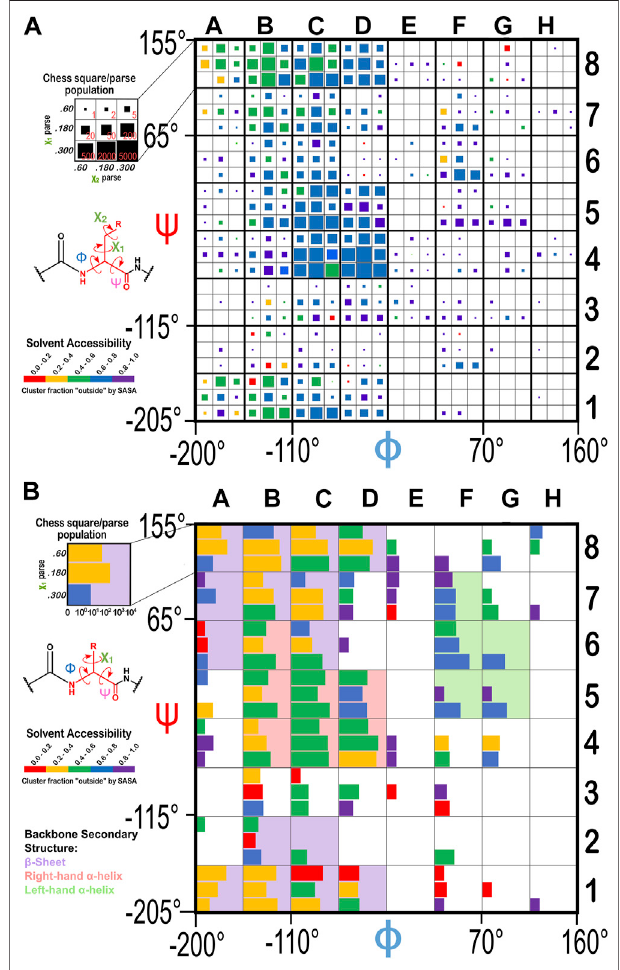
FIGURE 14 | Ramachandran chessboard displaying the chess square/ parse population for (A) glutamic acid and (B) histidine. The ( χ 1 / χ 2 ) parse populations for GLU are represented by colored squares with sizes as indicated on the legend. The ( χ 1 ) parse populations for HIS are represented in log 10 scale with colored bars. See also caption for Figure 1